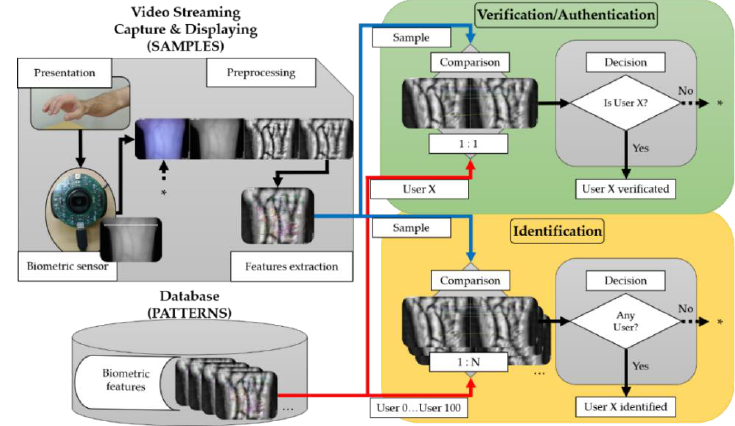
Figure 6. TGS-CVBR ® and PIS-CVBR ® union: Real-time authentication and identification process.